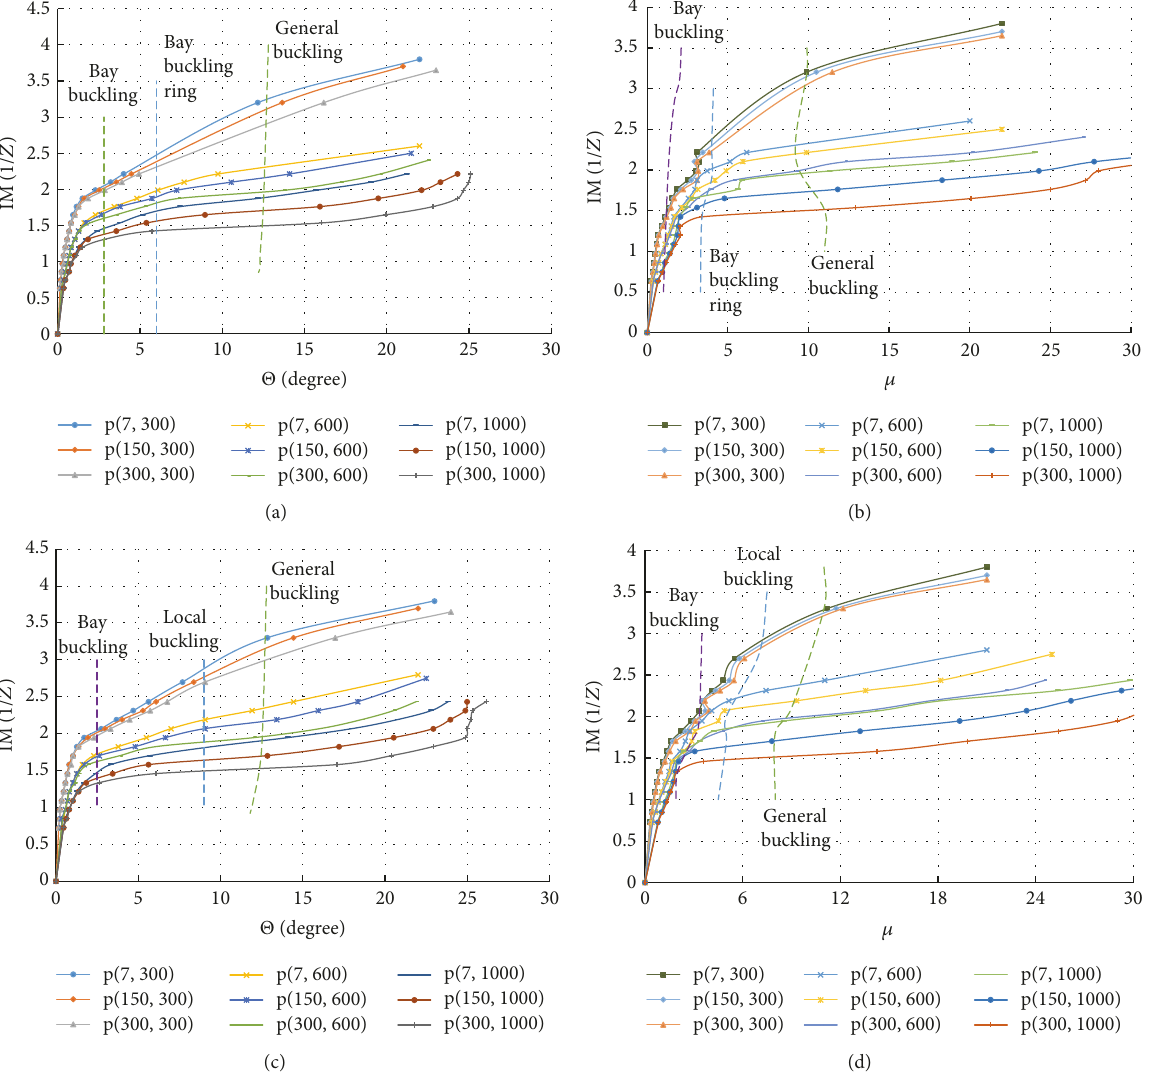
Figure 10: IEA curves obtained for ring-stiffened cylinder for all (𝛽, SD ) ’s, (e) IM- 𝜃 and (f) IM- 𝜇 , and ring- and longitudinal-stiffened cylinder, (g) IM- 𝜃 and (h) IM- 𝜇